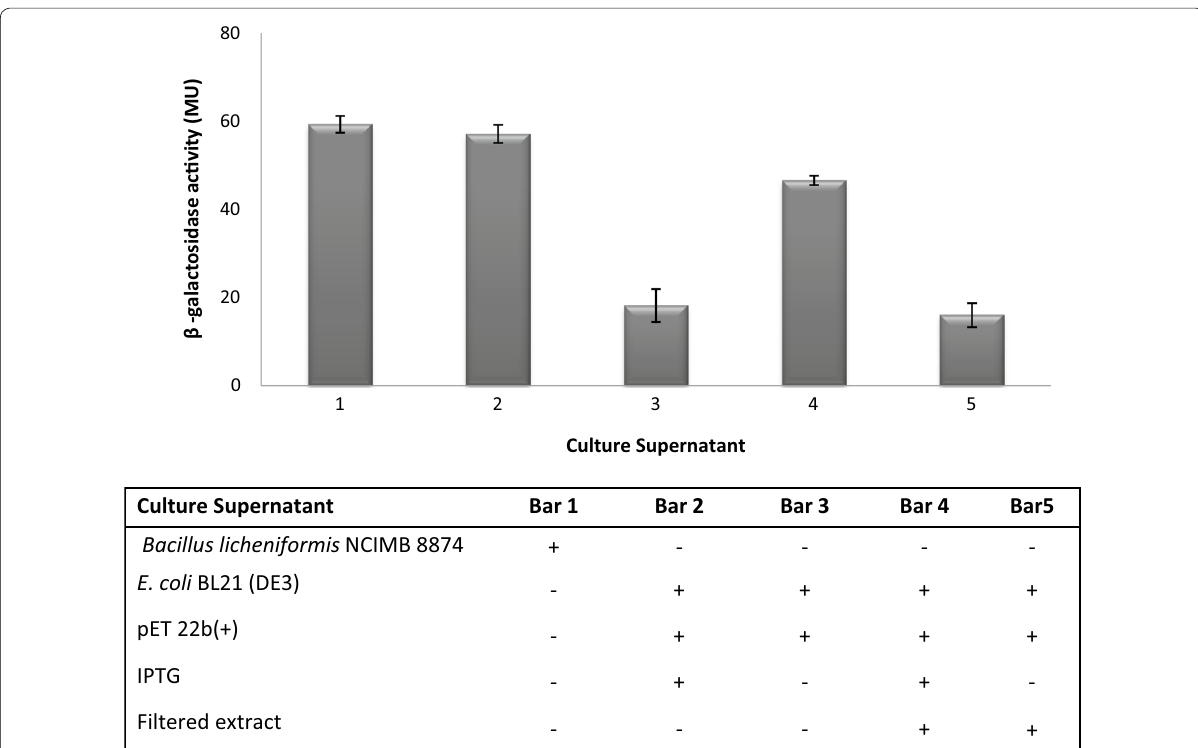
Fig. 6 ComX bioactivity in bacterial culture supernatants from late exponential phase B. licheniformis NCIMB 8874 and E. coli BL21 ectopically expressing a srfA - lacZ fusion, as determined through a β-galactosidase reporter ( B. subtilis JRL293). Data were collected from three independent experiments which were performed in triplicate. The constant blank (water) has been subtracted from all calculated values. The details of the tested culture supernatants are presented in the